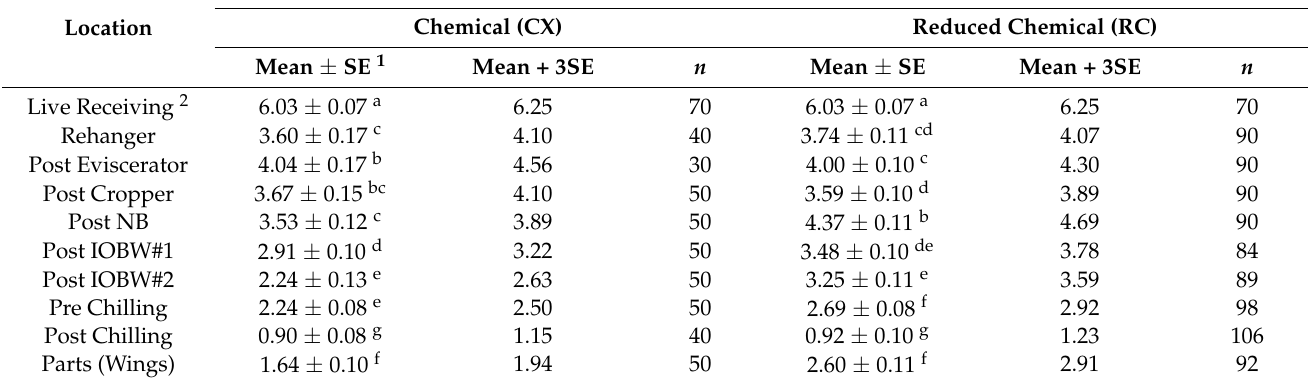
Table 2. Enterobacteriaceae counts (log CFU/mL) on each of the ten locations during the eviscera- tion process under normal process interventions (CX) and low-chemical process interventions (RC) on chicken rinses.